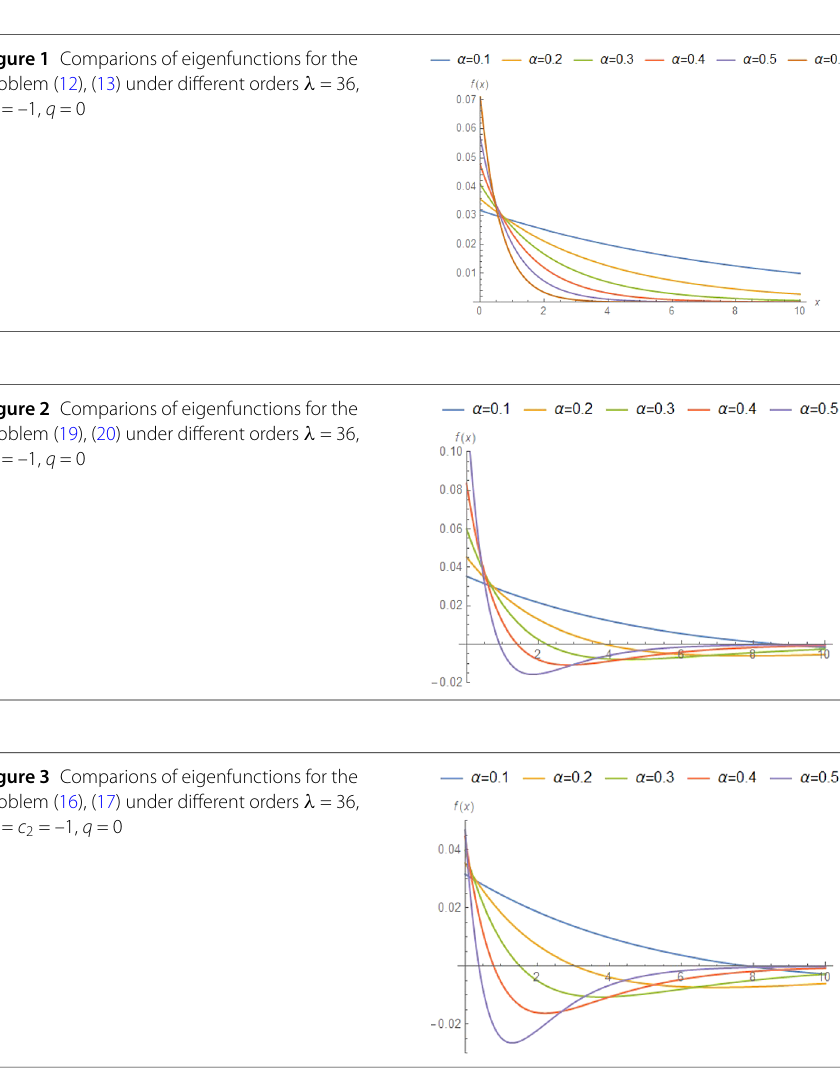
Figure 2 Comparions of eigenfunctions for the problem (19), (20) under different orders λ = 36, c 2 = –1, q = 0